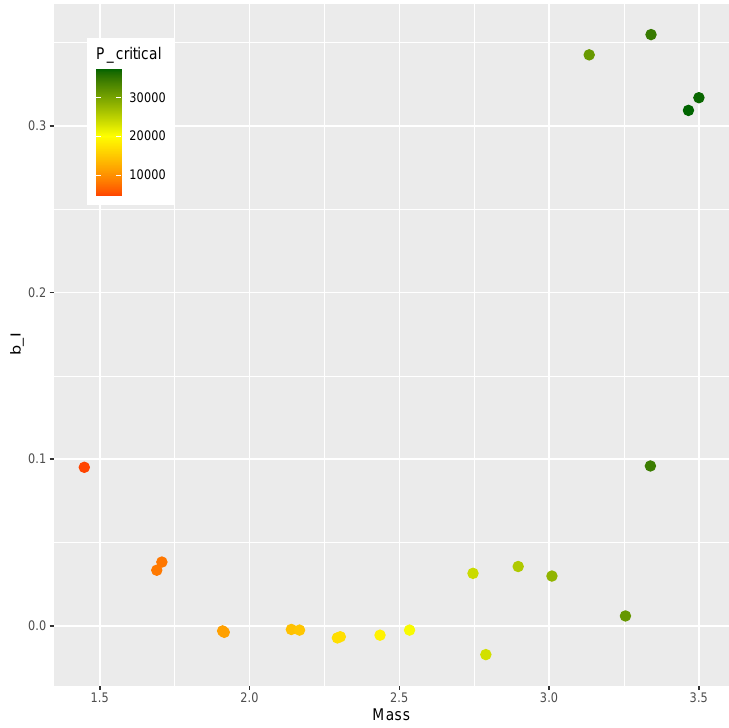
Figure 20. Mass m and b I at critical designs.